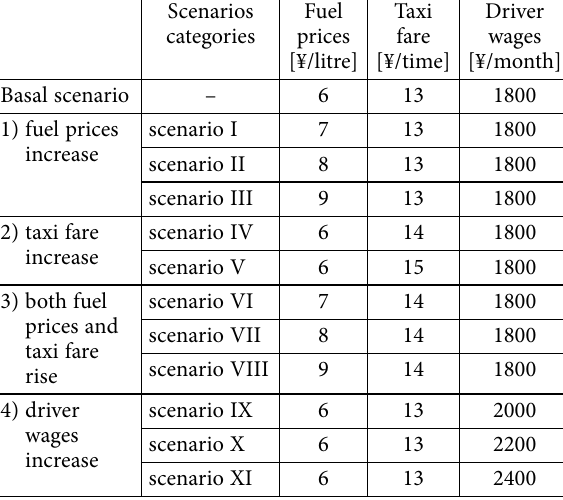
Table 5. Classification of taxi operational scenarios Scenarios